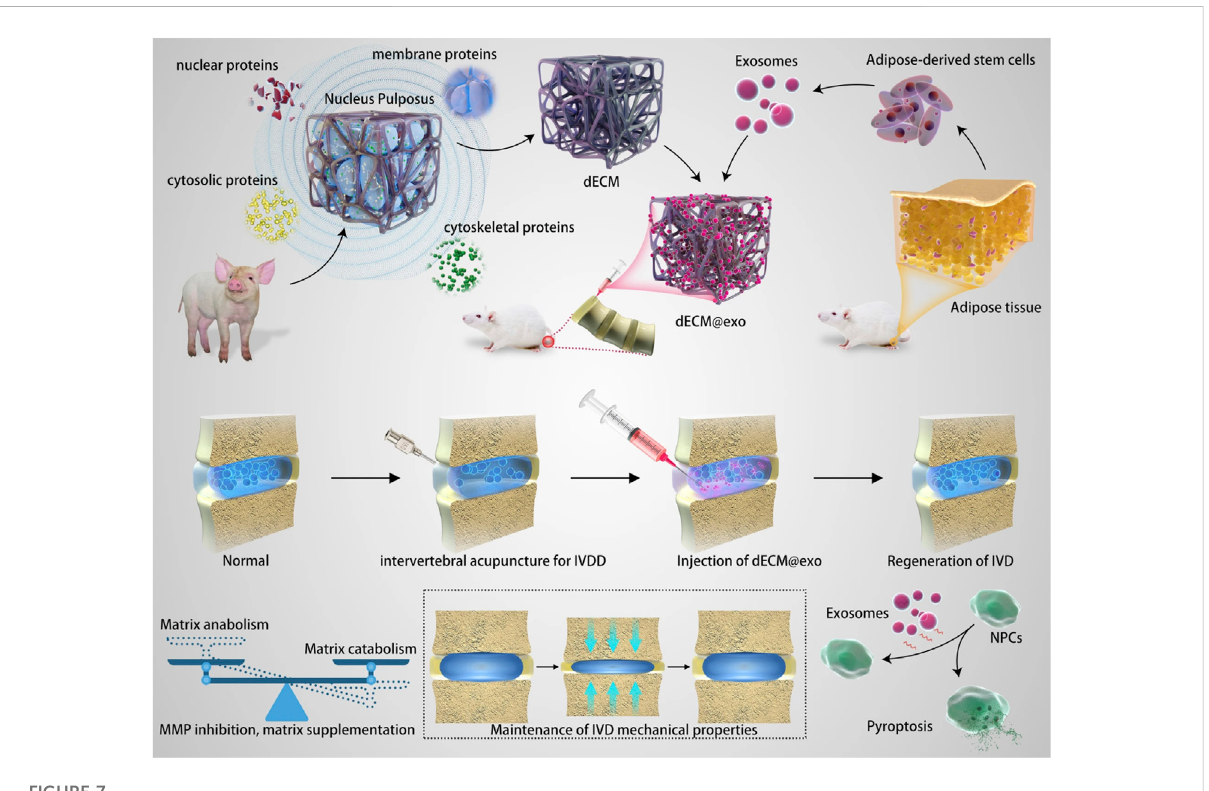
FIGURE 7 Schematic diagram of the mechanisms of one kind of multiscale drug delivery system combining thermosensitive acellular ECM hydrogels and adipose-derived MSC exosomes for IVD treatment. Reproduced with permission from (Xing et al.,